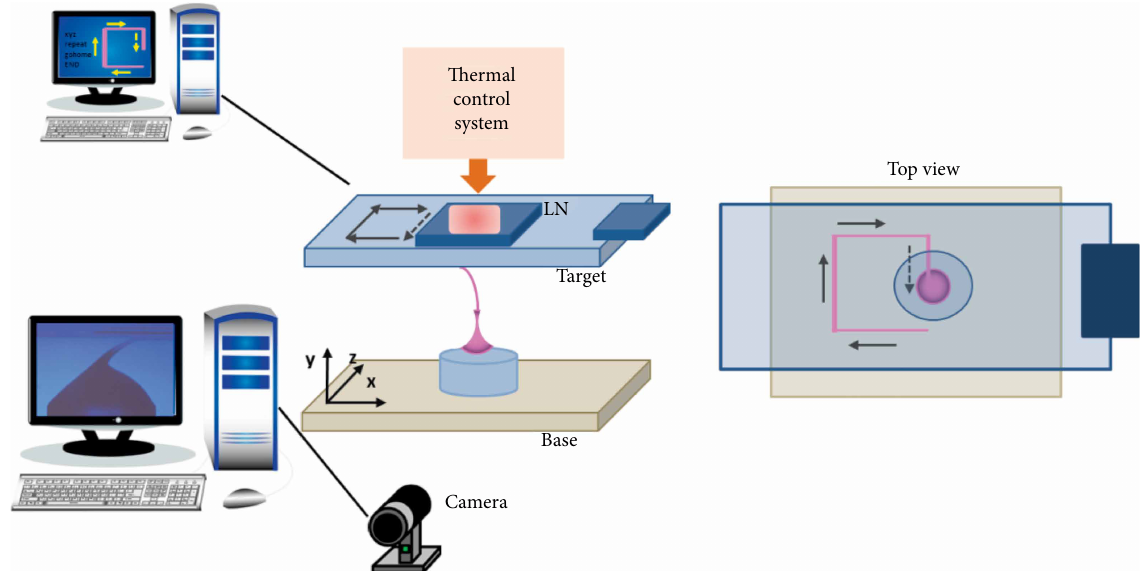
Figure 1: Outline of the set-up for layered 3D printing: the reservoir drop is sited under the LN crystal heated by a thermal control system. During the experiment real time visualization was ensured in order to control at the same time the jetting process and the target position. For the fabrication of layered architecture the target was moved along the the direction of